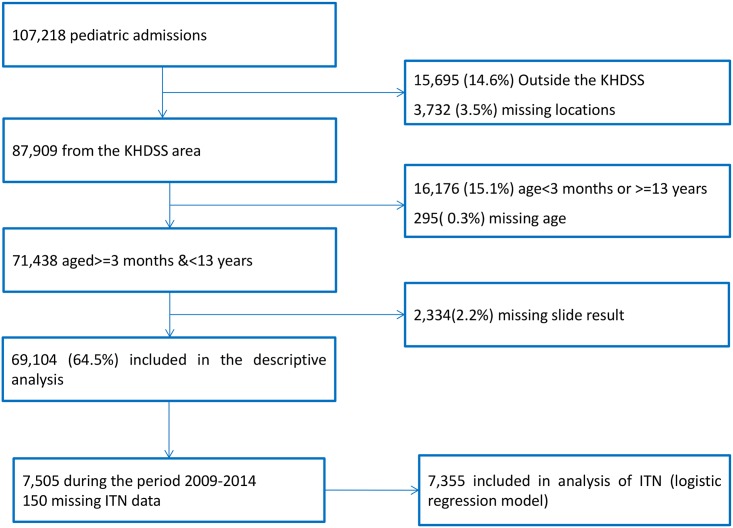
Flow diagram of participant numbers.Participant numbers and reasons for exclusion at each stage are shown.